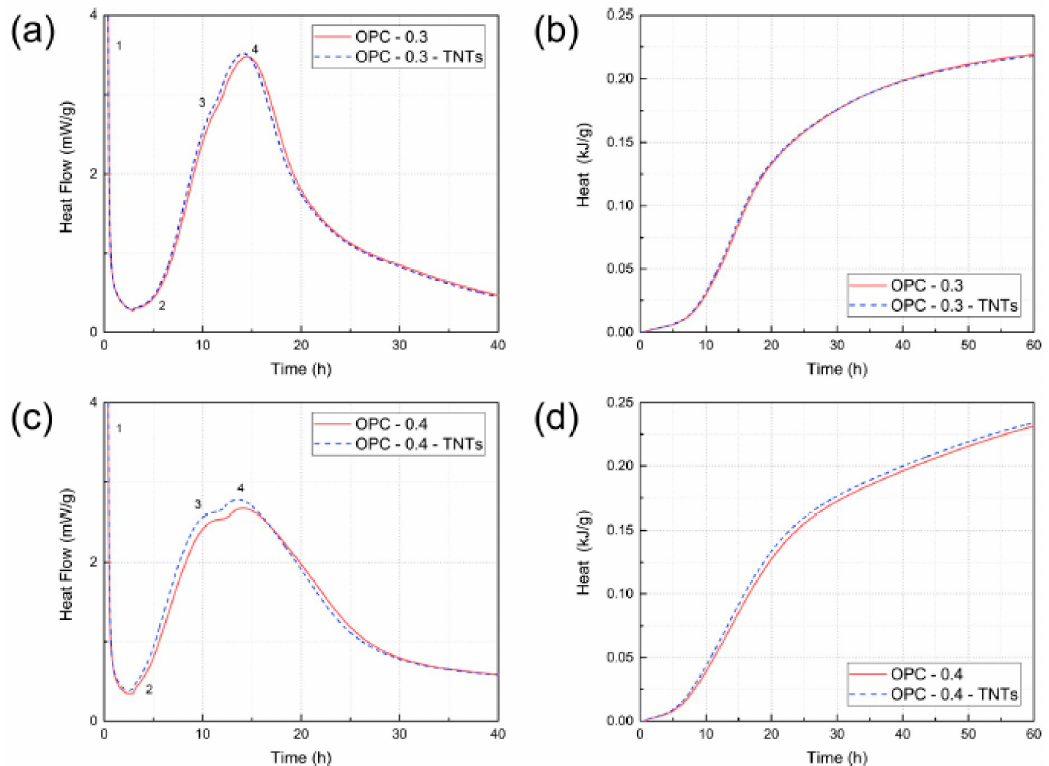
Figure 6. Rate of hydration measured by isothermal conduction. ( a ) Heat flow of OPC-0.3 with and without TNTs. ( b ) Total heat of hydration values calculated by integration of data in ( a ). ( c ) Heat flow of OPC-0.4 with and without TNTs. ( d ) Total heat of hydration values calculated by integration of data in ( c ).